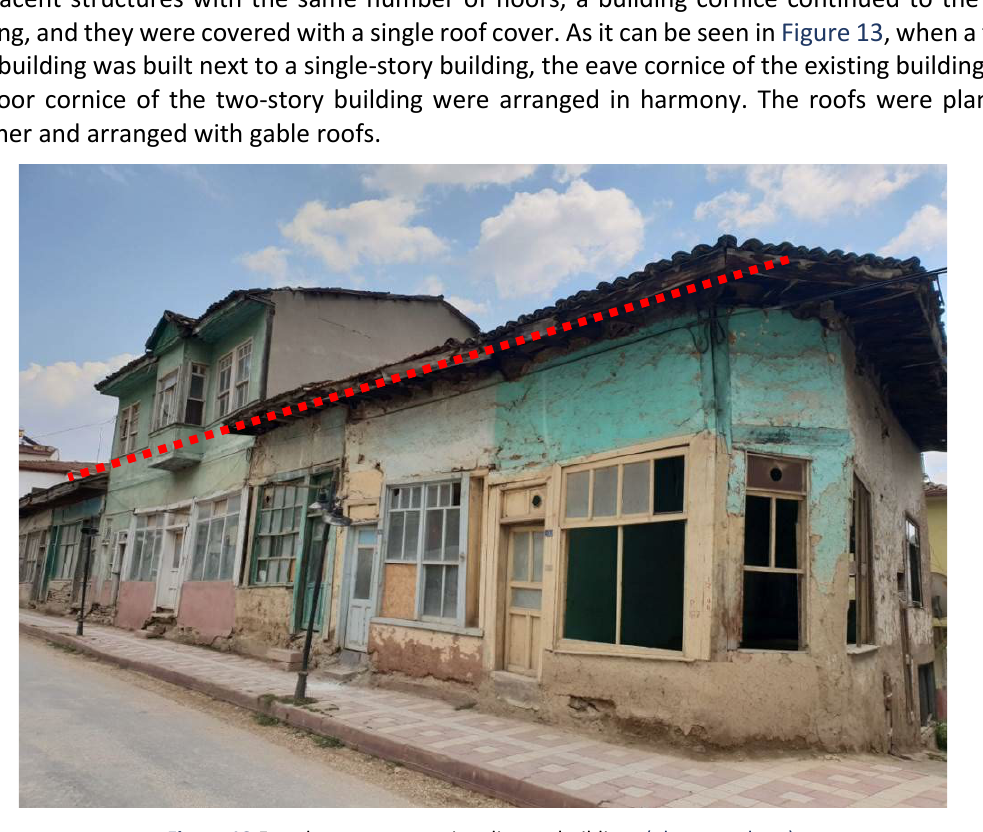
Figure 13 Facade arrangement in adjacent buildings (photo: